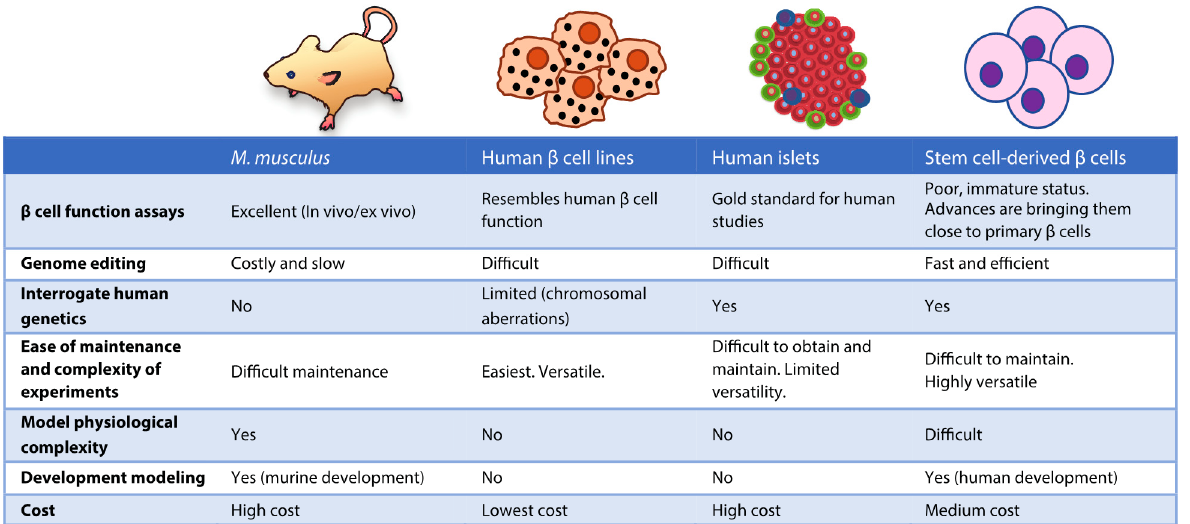
Figure 1. Comparison of model systems used in β cell research. Some of the advantages and limitations are summarized. Original illustrations except for vectorized laboratory mouse (CC BY-SA 3.0 license, David Liao).